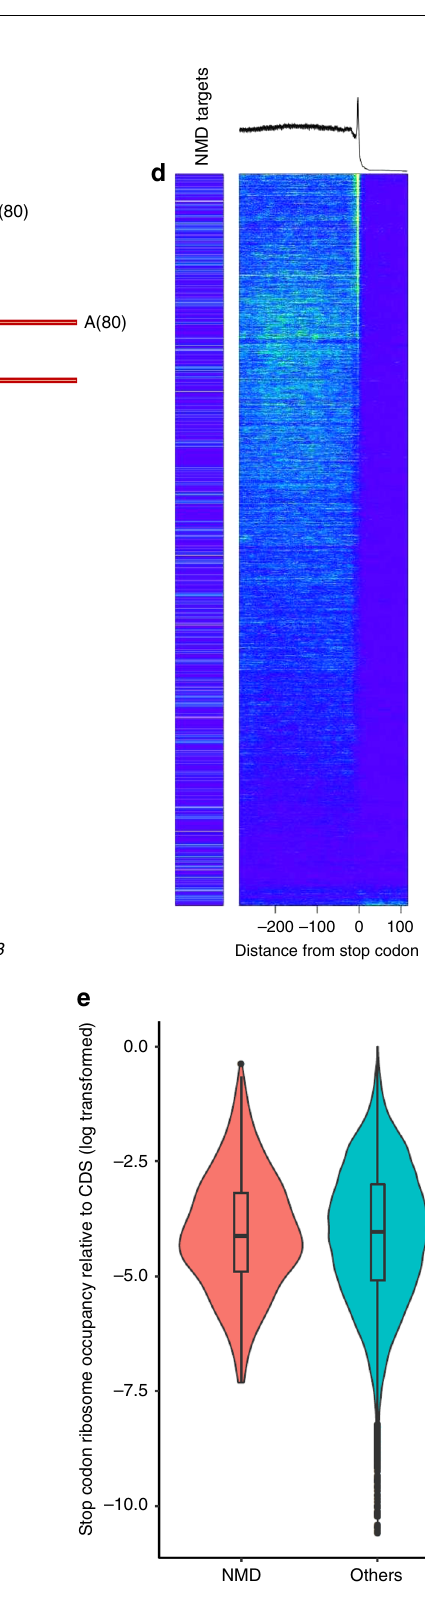
fully reconstituted eukaryotic systems allowed a detailed, stepwise functional interrogation of translation termination complexes and of the roles of release factors 26,27 . In this context, reconstituted translation is performed with isolated ribosomes that are sup- plemented with puri fi ed translation factors and aminoacylated tRNAs. The separate addition of each component allows tight